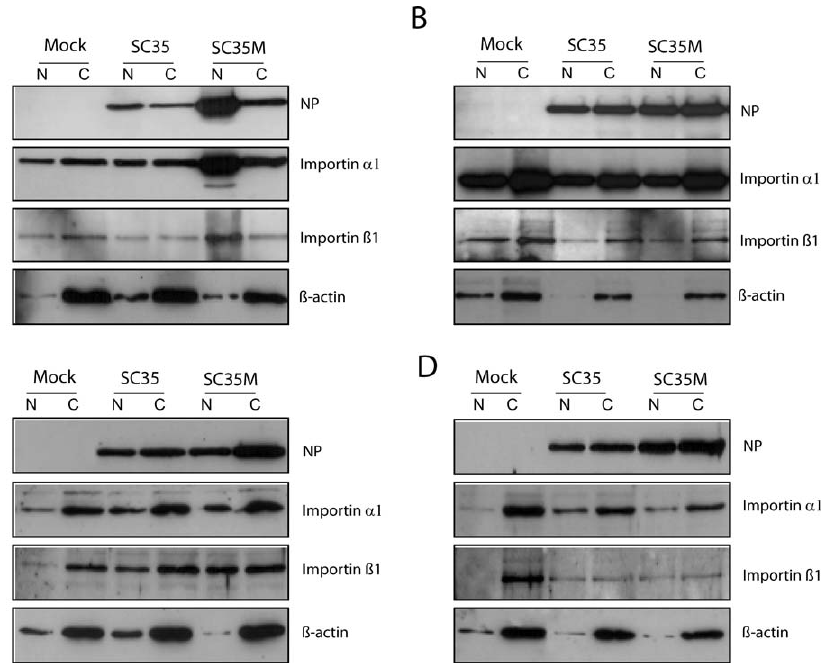
Figure 3. Importin a 1 Distribution in Mammalian and Avian Cells 293T or CEC-32 cells were infected at MOI 2 with SC35 or SC35M. 293T cells were harvested 6 h p.i. (A) and 12 h p.i. (B), and CEC-32 cells were harvested 9 h p.i. (C) and 18 h p.i. (D) and separated into nuclear and cytoplasmic fractions. NP, importin a 1, importin ß1, and ß-actin were determined by Western blot analysis.